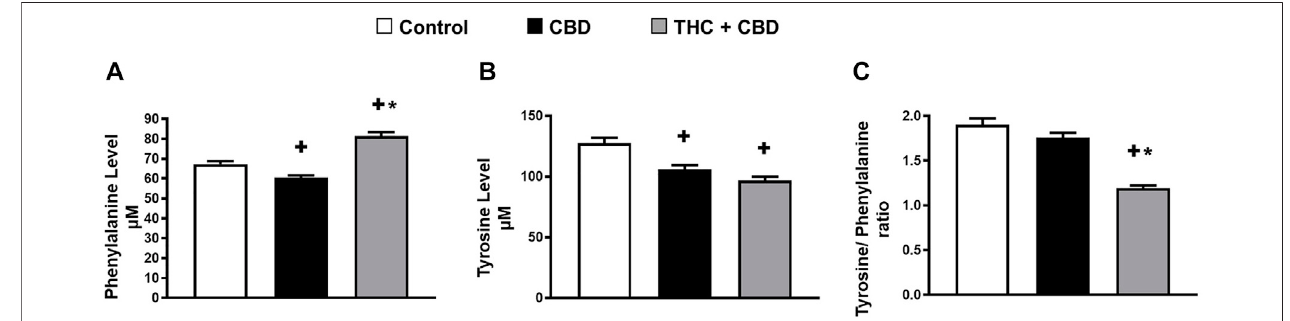
FIGURE4| Full-spectrumcannabisextractmaysigni fi cantlyreducephenylalaninehydroxylaseenzymeactivity. (A) Serumlevelofphenylalanine; (B) serumlevelof tyrosine, and (C) the ratio of tyrosine to phenylalanine (phenylalanine hydroxylase) in vehicle-treated, broad-spectrum cannabis extract – treated, and full-spectrum cannabis extract – treated rats (n = 10). Results are shown as mean ± SEM. Comparisons between three groups were made by one-way ANOVA with a Tukey – Kramer post hoc multiple comparison test. + p < 0.05 vs. vehicle group. * p < 0.05 vs. full-spectrum cannabis extract